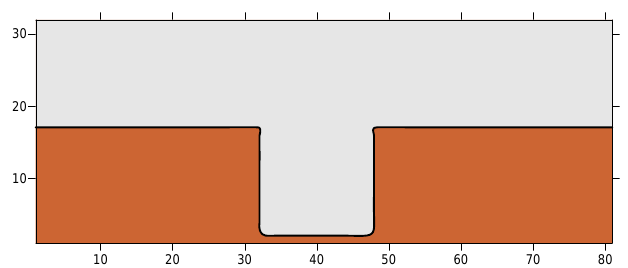
Figure 3. The simulated coastal zone with the grid for the study of the